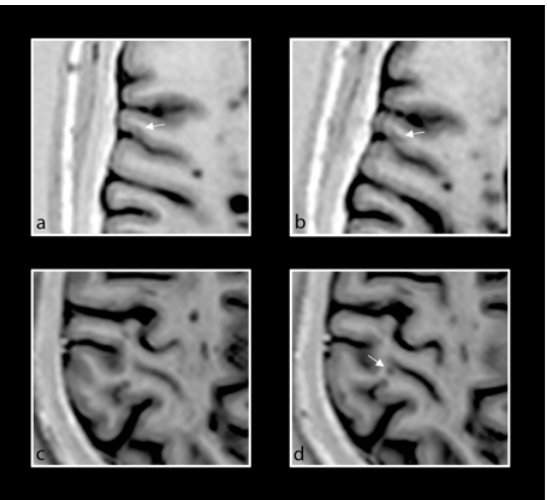
Fig 3. Retrospective analysis of new PSIR cortical lesions. Baseline and follow-up axial PSIR images of different patients with primary progressive MS demonstrating focal lesions in the cortical grey matter. Intracortical lesion that was too small to be counted at baseline (a, white arrow), but that enlarged and was counted on follow-up scan (b, white arrow). New LC lesion (d, white arrow) noted at follow-up but not at baseline